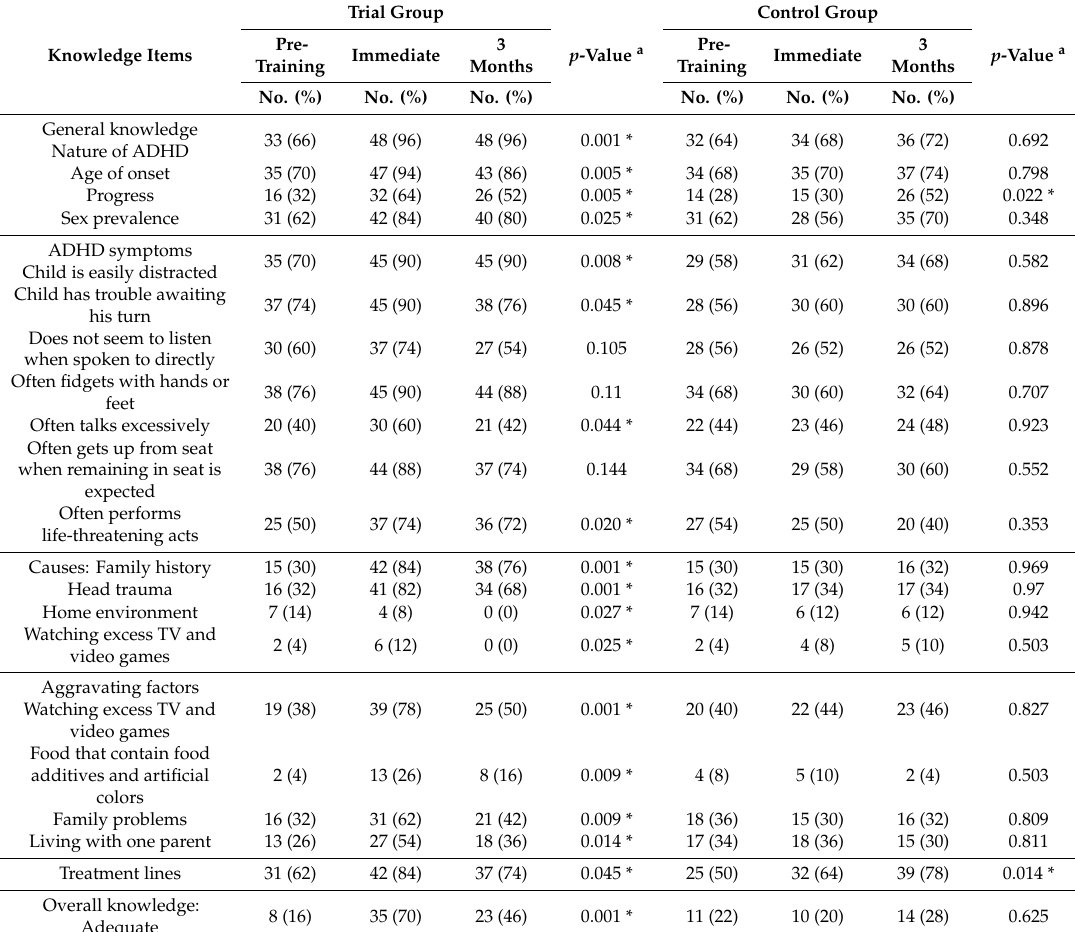
Table 1. Proportion of teachers’ correct responses to ADHD knowledge assessment questionnaire in the three study phases in trial and control groups ( n =